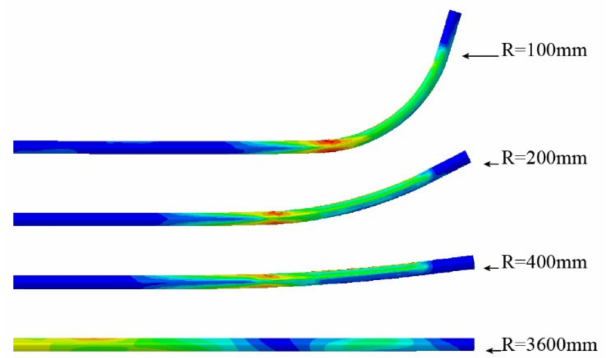
Figure 13. Tube forming in FEM